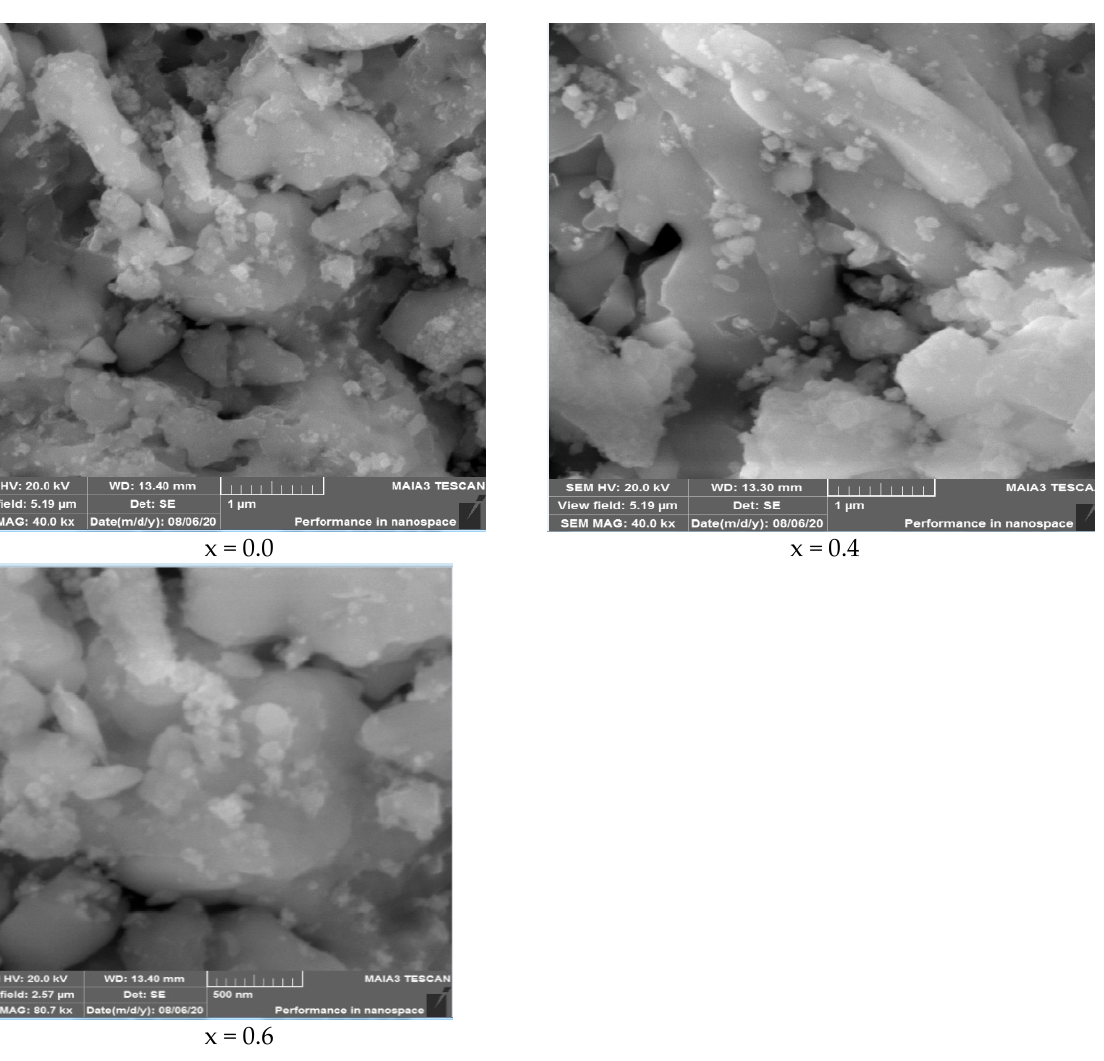
Figure 3. SEM images of Cu 1 − x Ni x Cr 2 O 4 (x = 0.0, 0.4, and